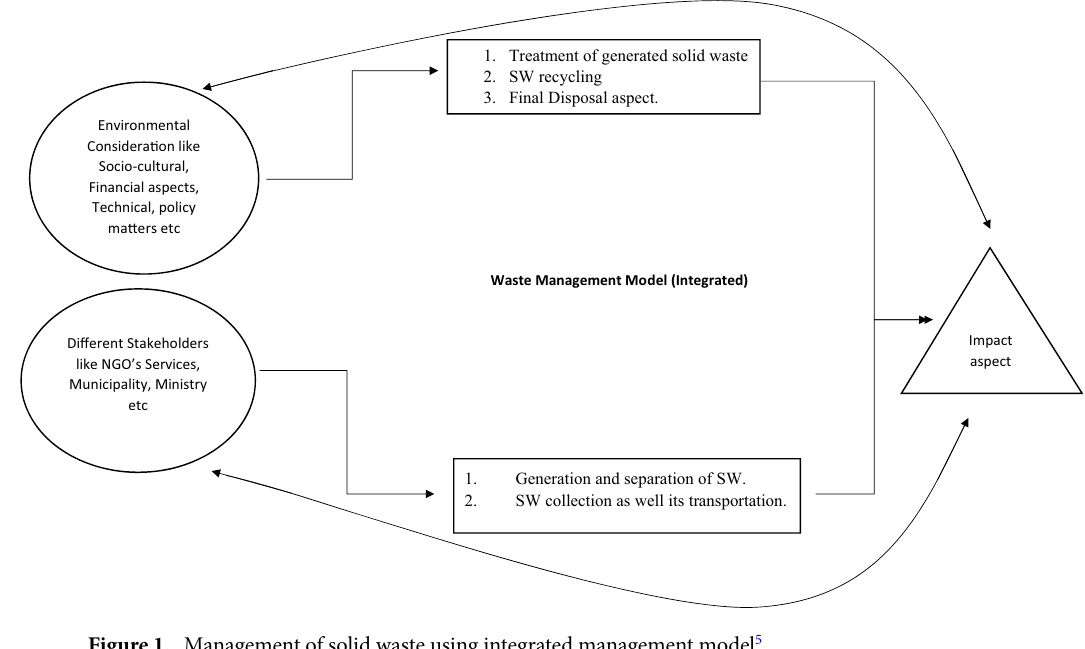
Figure 1. Management of solid waste using integrated management model 5